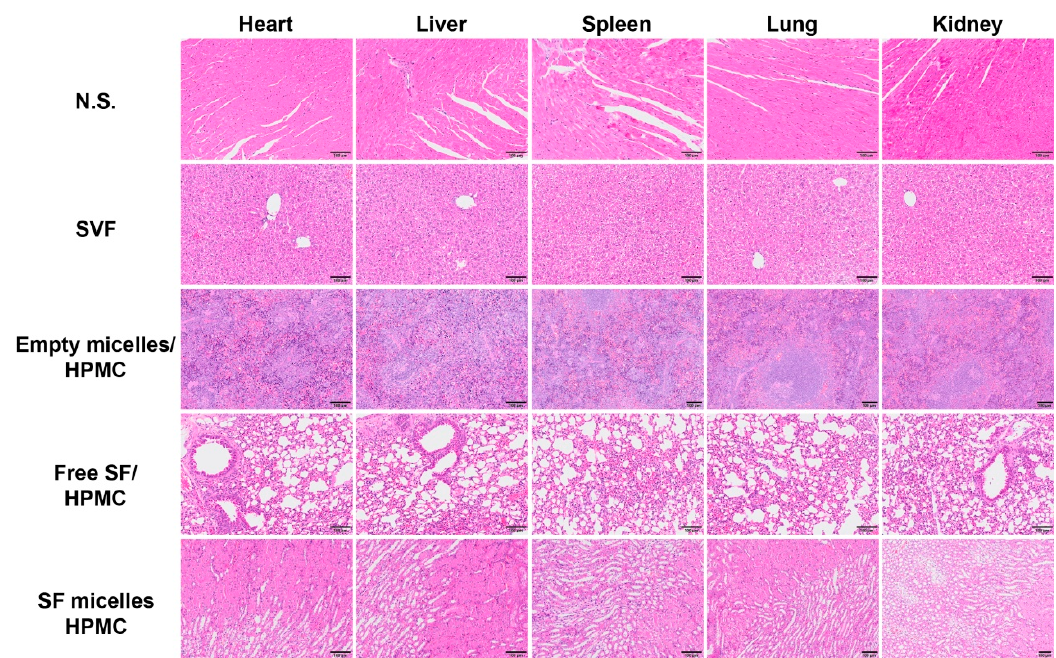
Figure A7. Inhibition rate of tumor weight by the end of treatment. Significance criteria: * p < 0.05, ** p < 0.001.